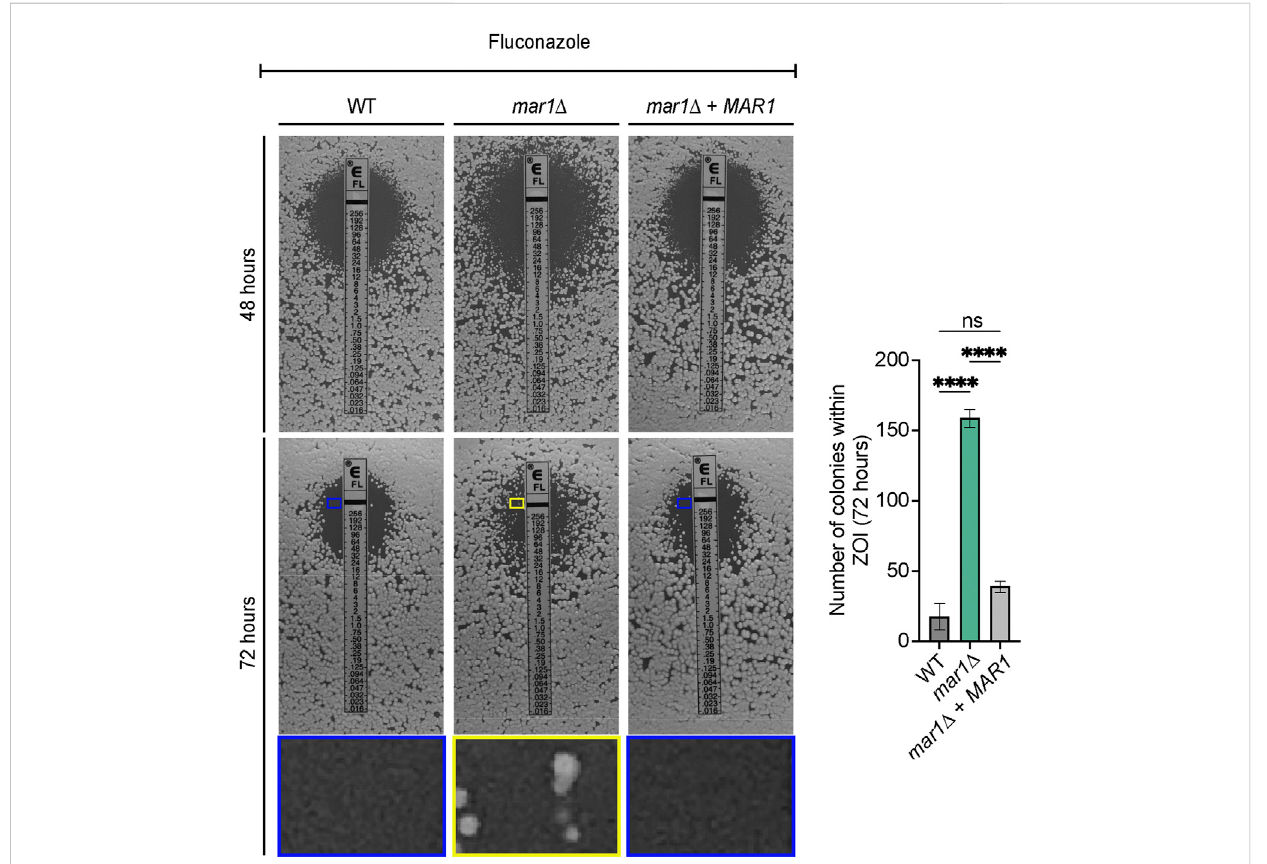
FIGURE 8 Mar1 contributions to fl uconazole susceptibility. Fluconazole susceptibility and tolerance was assessed for the WT strain, the mar1 Δ mutant strain, and the mar1 Δ + MAR1 complemented strain. Strains were normalized by OD 600 and were subsequently grown on YPD medium agar plates in the presenceof fl uconazoleEteststrips(bioMérieux).Cellswereincubatedat30 ° Candplateswereimagedattheindicatedtimes.Fluconazoletolerancewas identi fi ed by the appearance of small colonies within the zone of inhibition at 72 h. The average number of colonies growing within the zone of inhibition at 72 h for each strain across four biological replicates ( n = 4) is also included. Error bars represent the SEM. Statistical signi fi cance was determined using one-way ANOVA and the Tukey-Kramer test (****, p < 0.0001; ns, not signi fi cant). ZOI, zone of inhibition. Colored boxes in the middle panels indicate inset images in the bottom panels (blue boxes = WT strain and mar1 Δ + MAR1 complemented strain, inside the zone of inhibition; yellow box = mar1 Δ mutant strain, inside the zone of